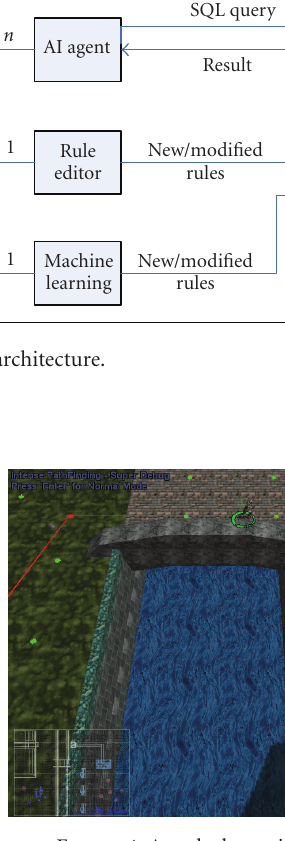
Figure 4: A path shown in Debug